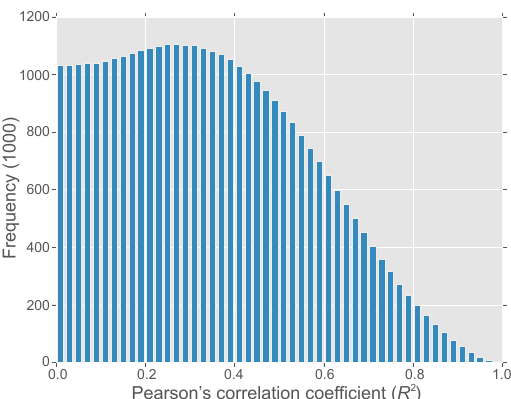
Figure 1. Distribution of correlations for all pairs of M. oryzae genes. Pearson’s Correlation Coefficient (R 2 ) are reported as absolute values.